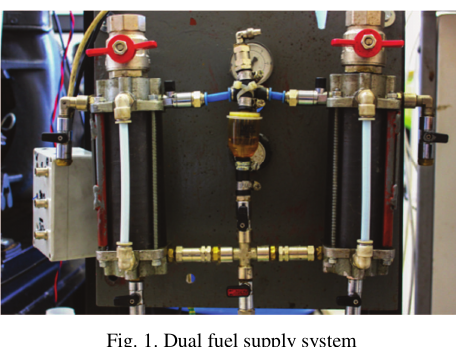
Fig. 1. Dual fuel supply system